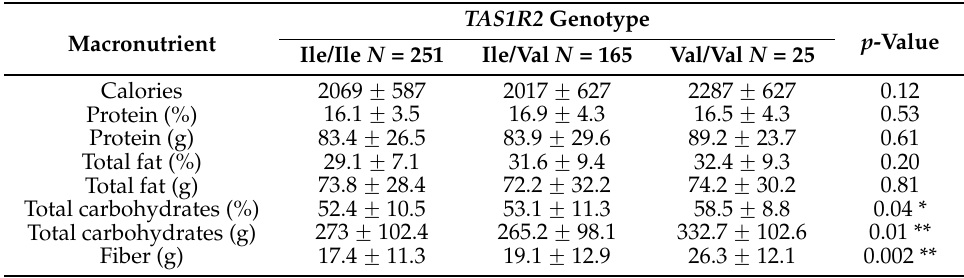
Table 2. Average daily intake of macronutrients by TAS1R2 genotype.